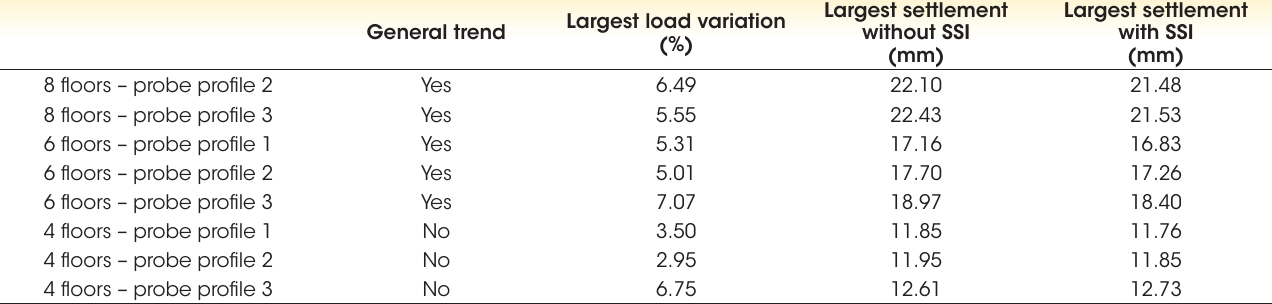
Summary of the behavior of the loads and settlements